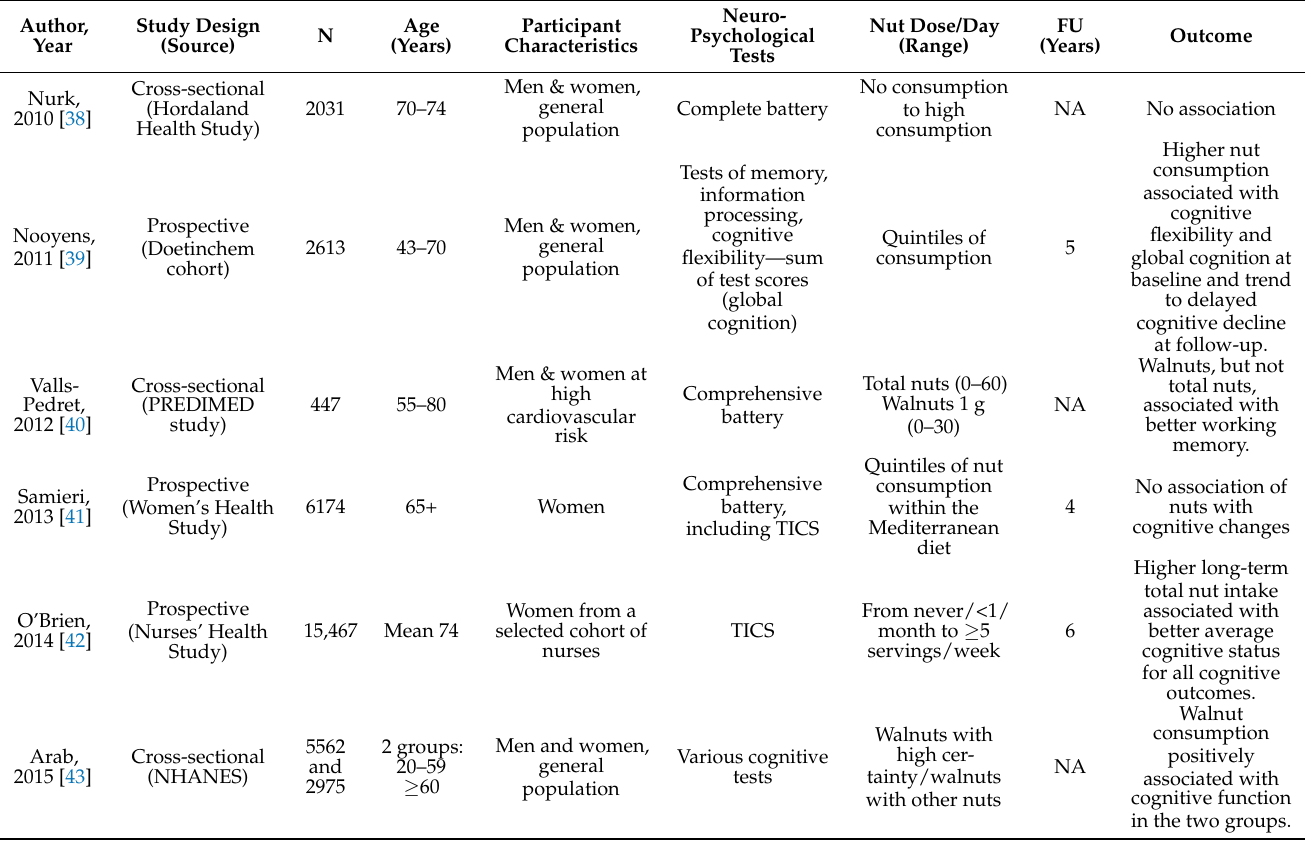
Table 1. Epidemiological studies examining the association of nut consumption with cognitive